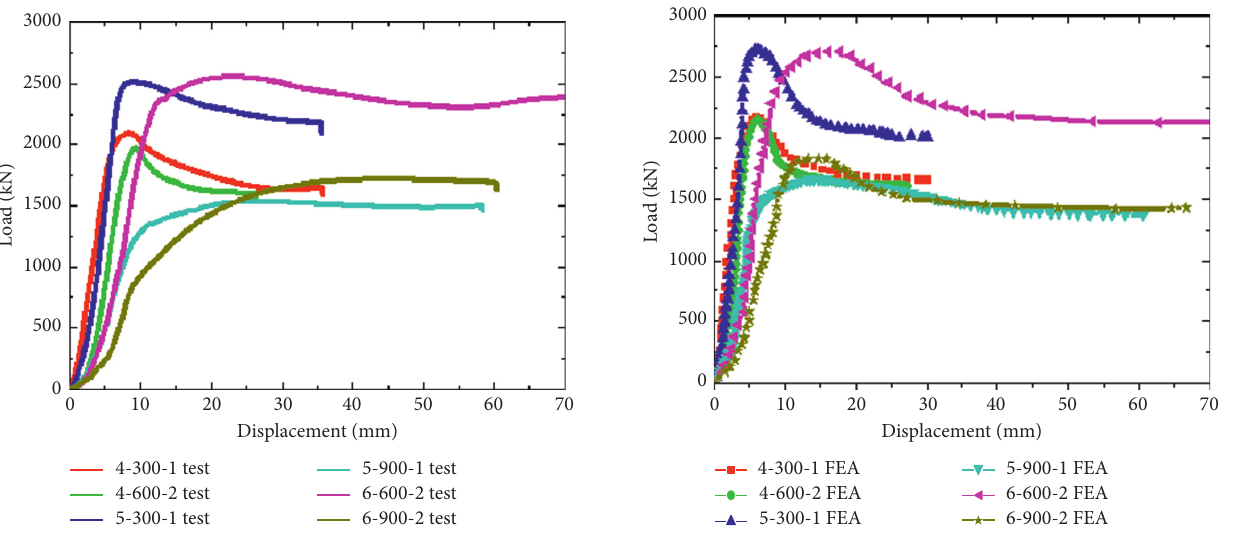
Figure 20: Load-displacement curve of the specimen. Figure 21: Load-displacement curve of